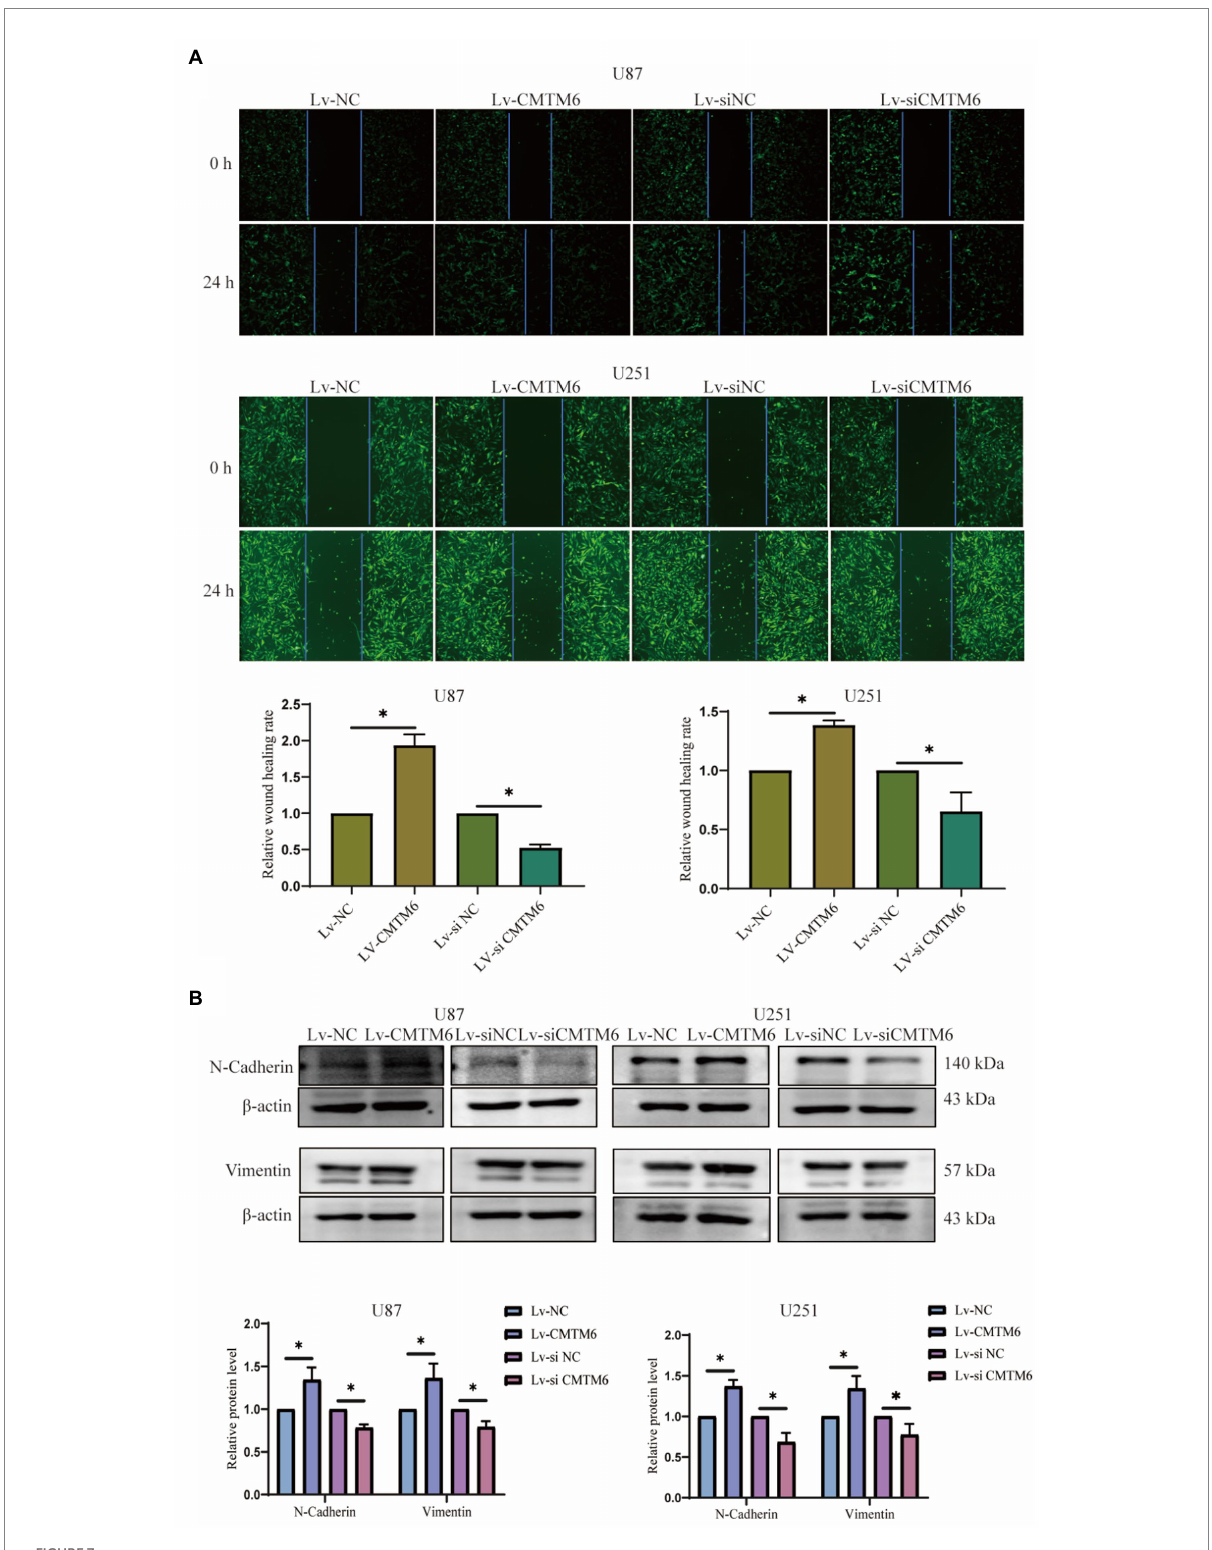
FIGURE 7 Relationship of CMTM6 with U87, U251 cell migration and EMT. (A) Figures of wound healing experiments and results analysis of cells after up and down regulation of CMTM6. (B) Western blot and result analysis of N-Cadherin and Vimentin proteins in cells after up and downregulation of CMTM6. * p <